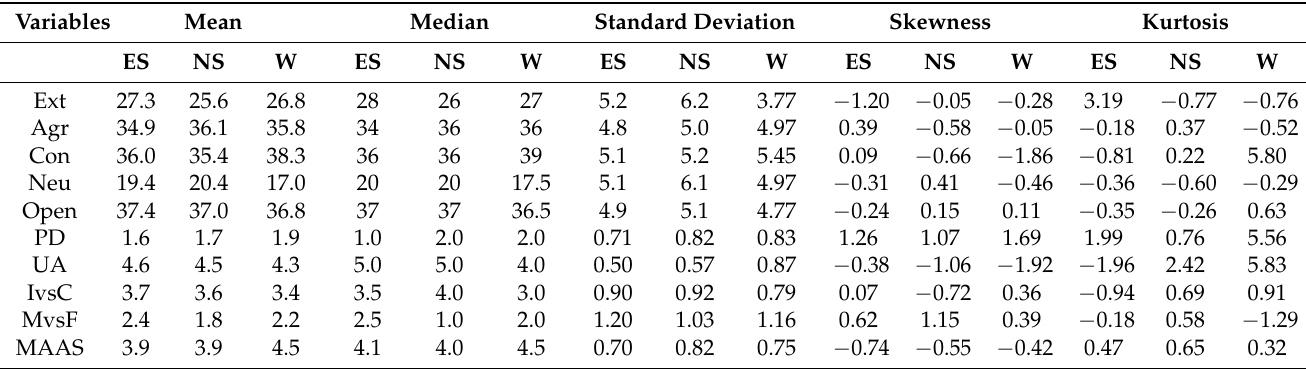
Table 3. Descriptive statistics of